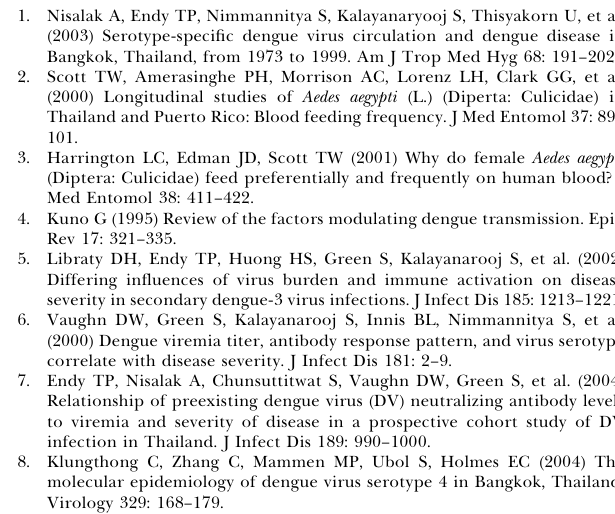
Figure S1. The Predicted Probability of Infection for Enrollees within Positive Clusters as a Function of Distance to the Index House The probabilities are given for males and females ages 3, 8, and 13 y. Model parameters are reported in Table 5. Found at doi:10.1371/journal.pmed.0050205.sg001 (51 KB DOC).